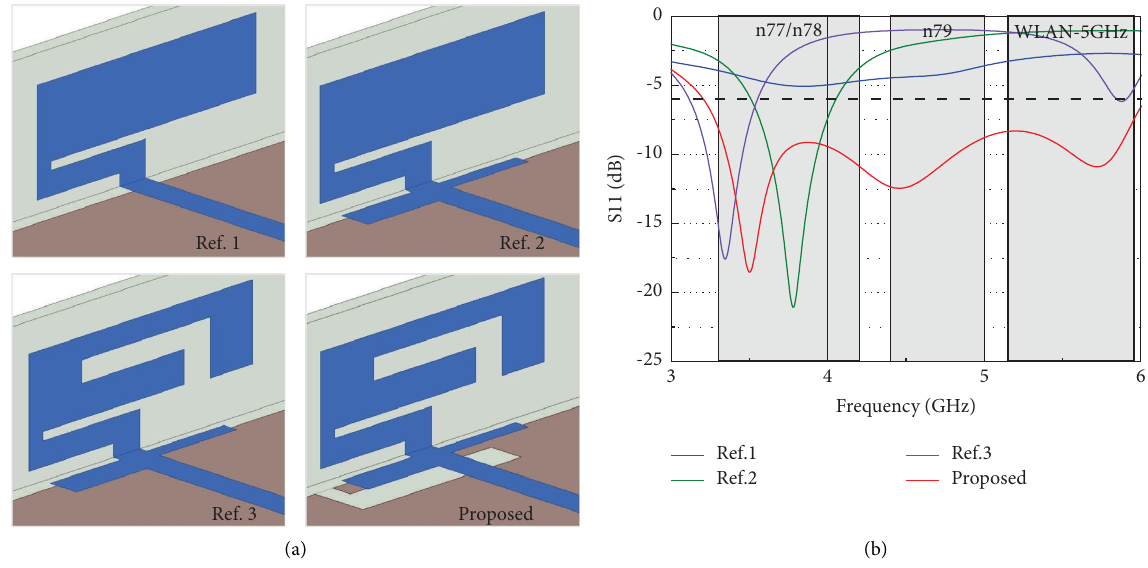
Figure 2: (a) Te design steps and (b) its corresponding S parameters of the proposed antenna